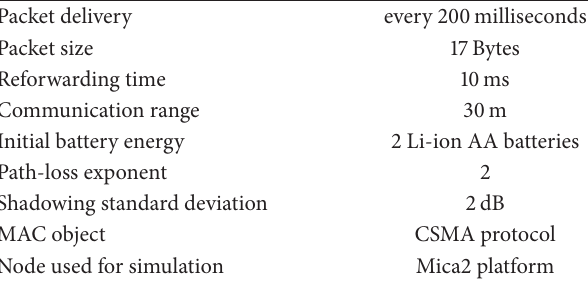
Table 1: Simulation parameters.